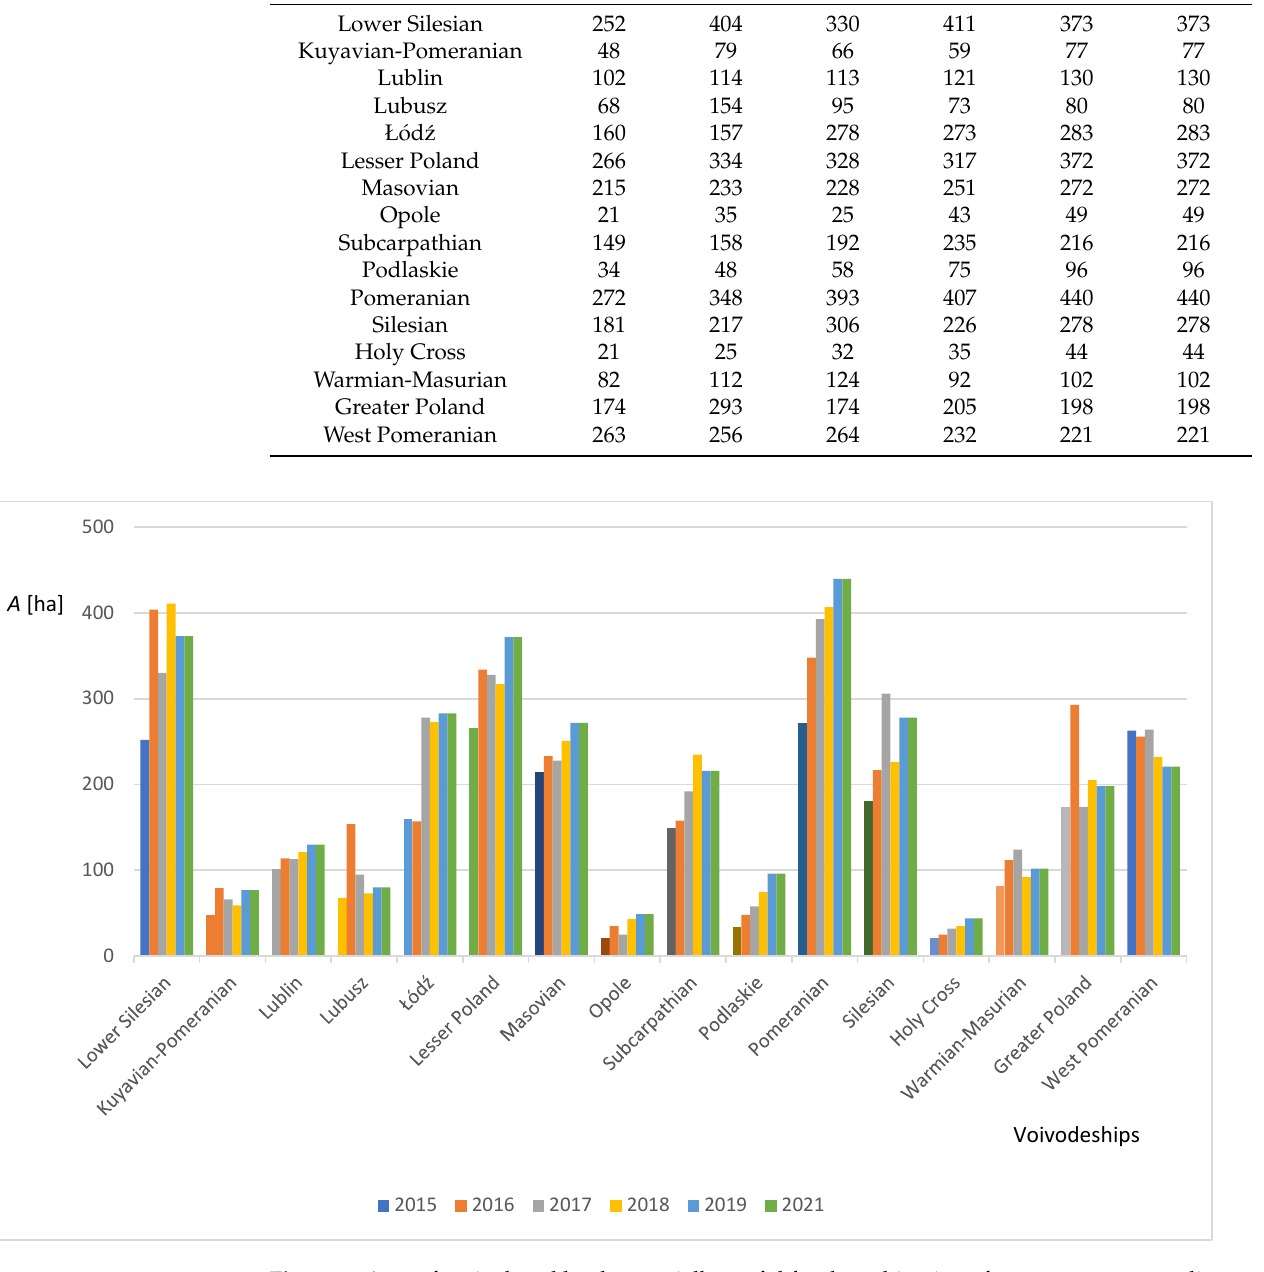
Figure 6. Area of agricultural land potentially useful for the cultivation of energy crops, according to Table 19 (own elaboration).